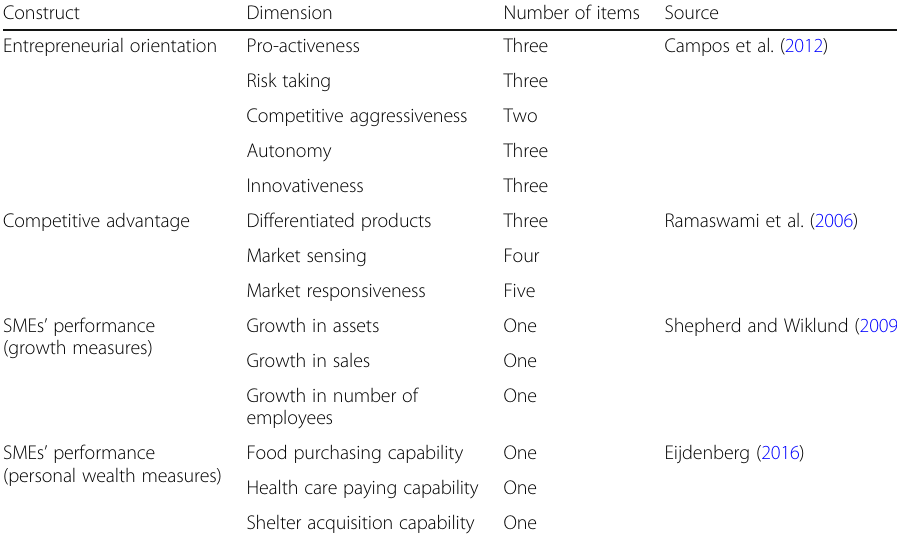
Table 1 Measurement of model